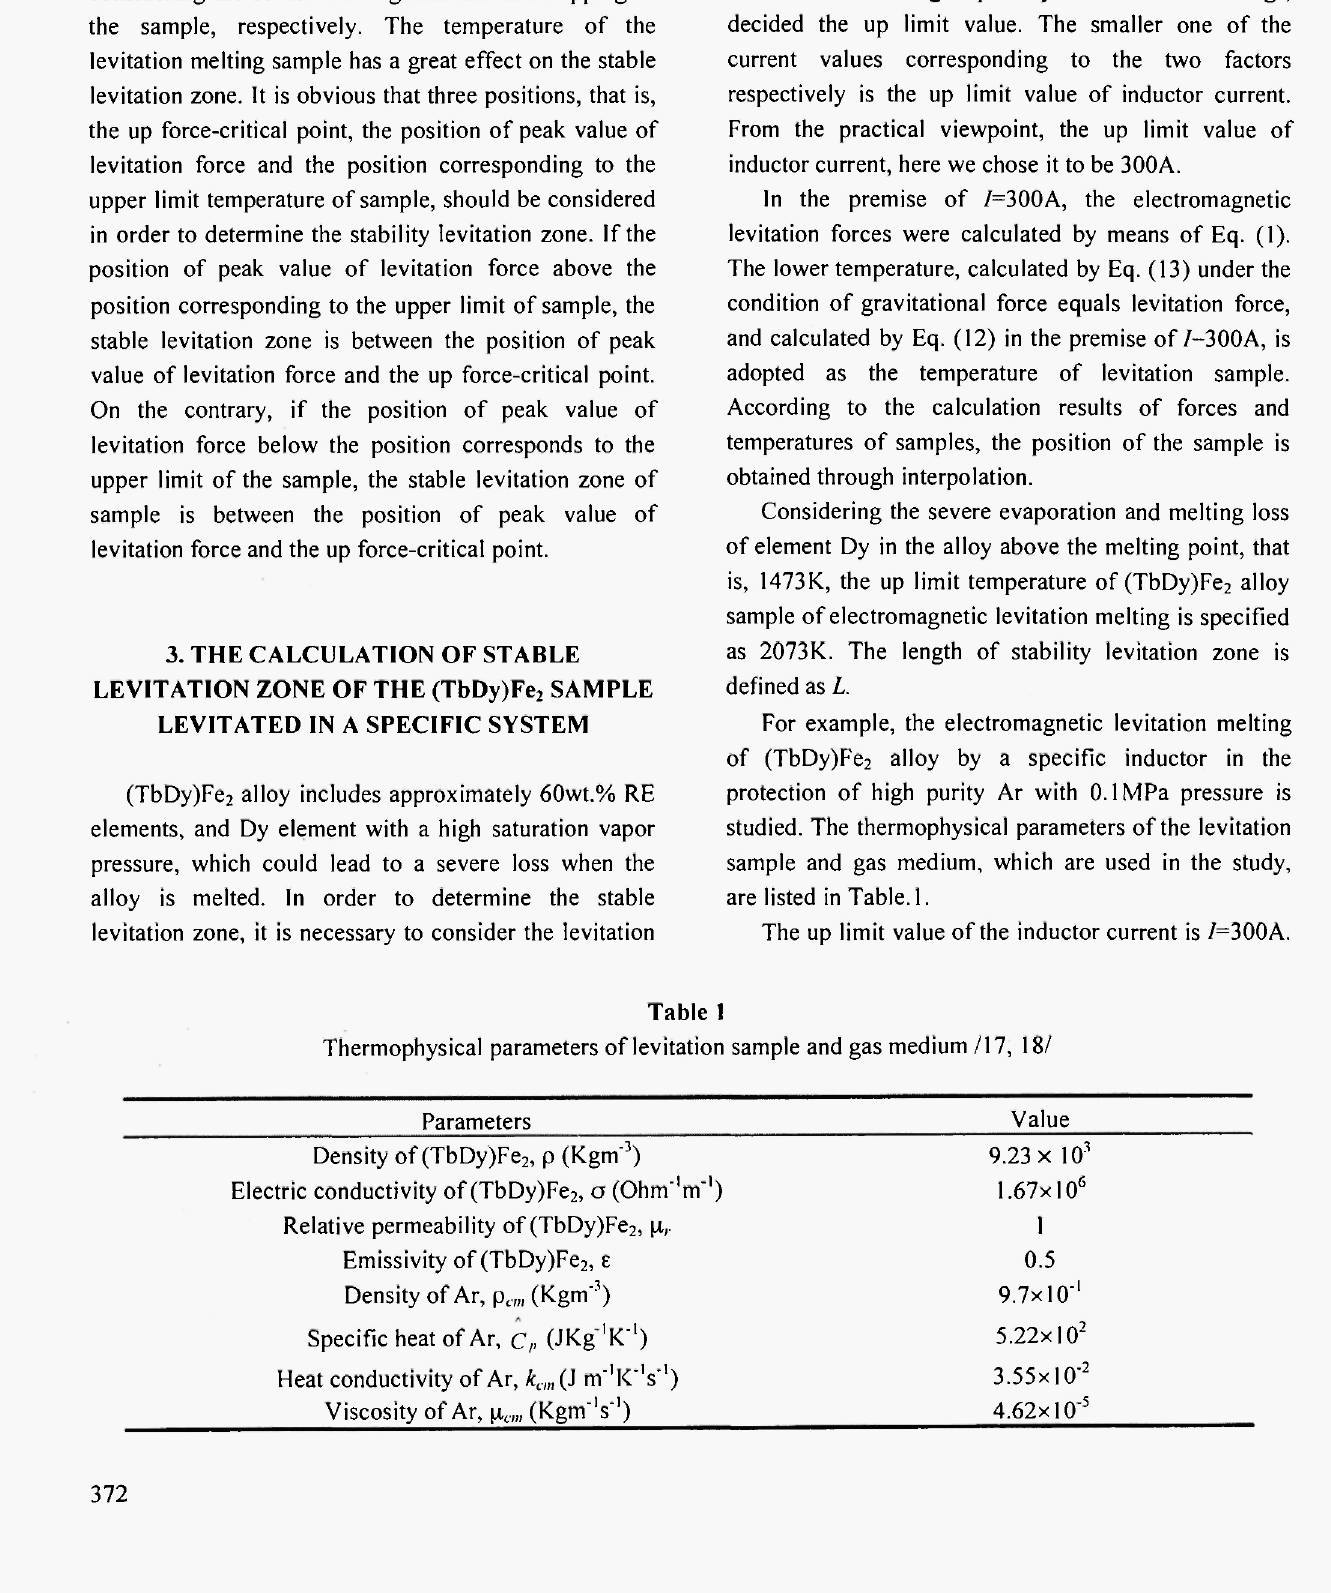
Thermophysical parameters of levitation sample and gas medium /17, 18/